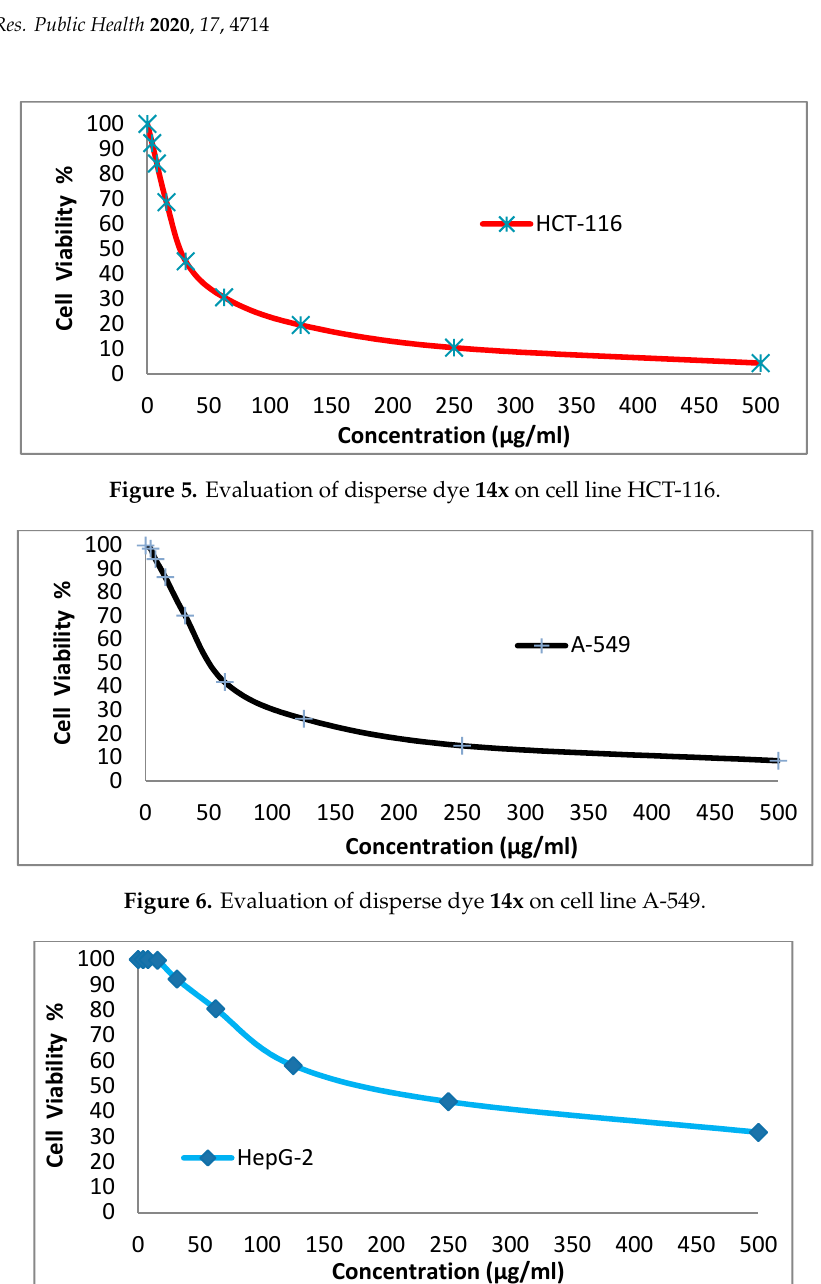
Figure 7. Evaluation of disperse dye 14y on cell line HepG-2.